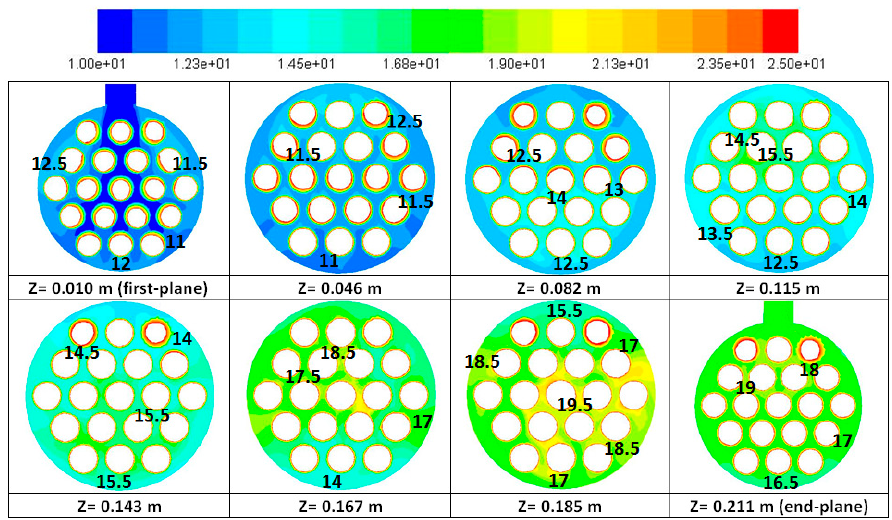
Figure 14. Prediction of temperature (°C) distribution at section planes defined in shell side (Case-V).